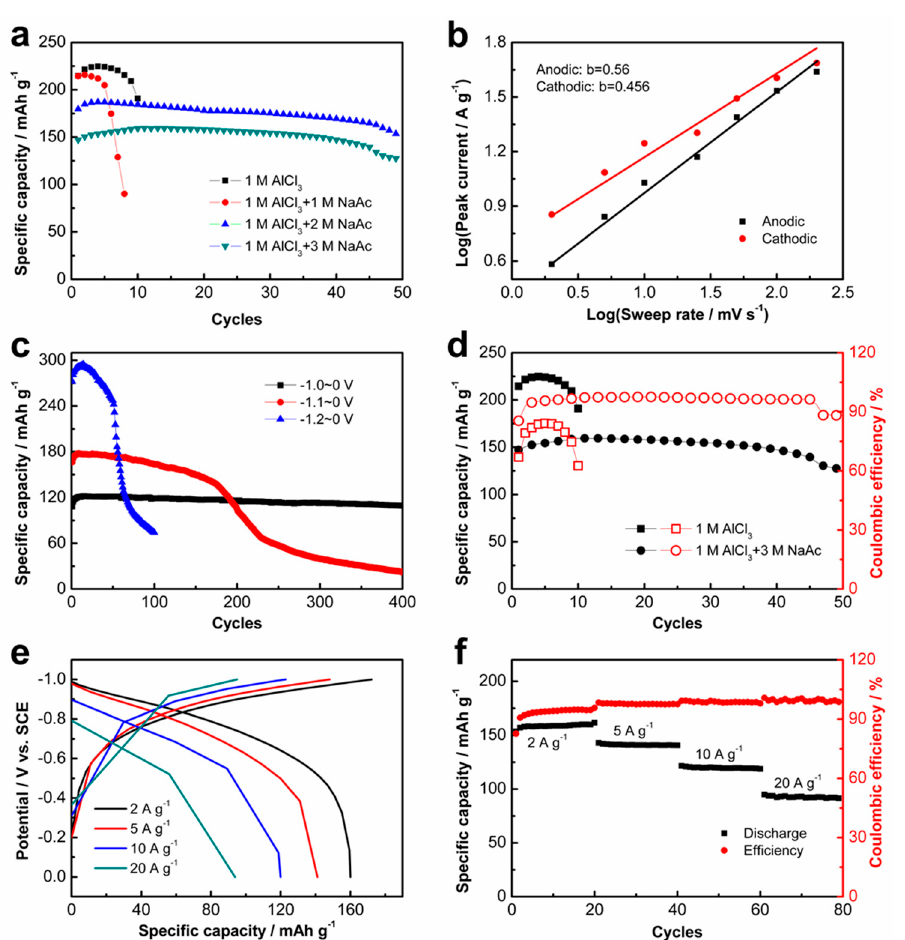
Figure 3. Electrochemical performance of K 2 Ti 8 O 17 electrode in the AlCl 3 /NaAc aqueous electrolyte. ( a ) CV curves at different potential ranges with scan rate of 25 mV s − 1 . ( b ) Corresponding dependency of b-value for redox peak currents on the logarithm of the sweep rates calculated based on CV curves in Figure S4b. ( c ) GCD curves with different potential ranges at the current density of 10 A g − 1 . ( d ) Cycling performance in areal specific capacitances with current density of 2 A g − 1 . ( e ) GCD curves with different current densities in the potential range from − 1 to 0 V VS. SCE . ( f ) Discharge capacitance and corresponding coulombic efficiencies at current densities ranging from 2 to 20 A g − 1 in a potential range from − 1 to 0 V VS. SCE .